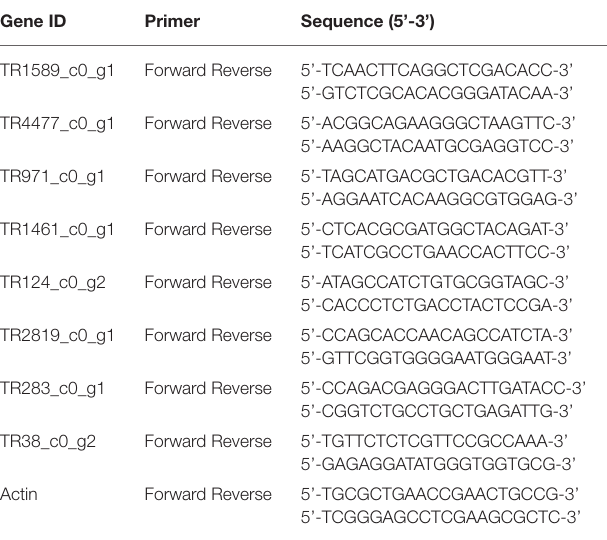
TABLE 1 | Primers of eight DEGs used for gene expression analysis by RT-qPCR.